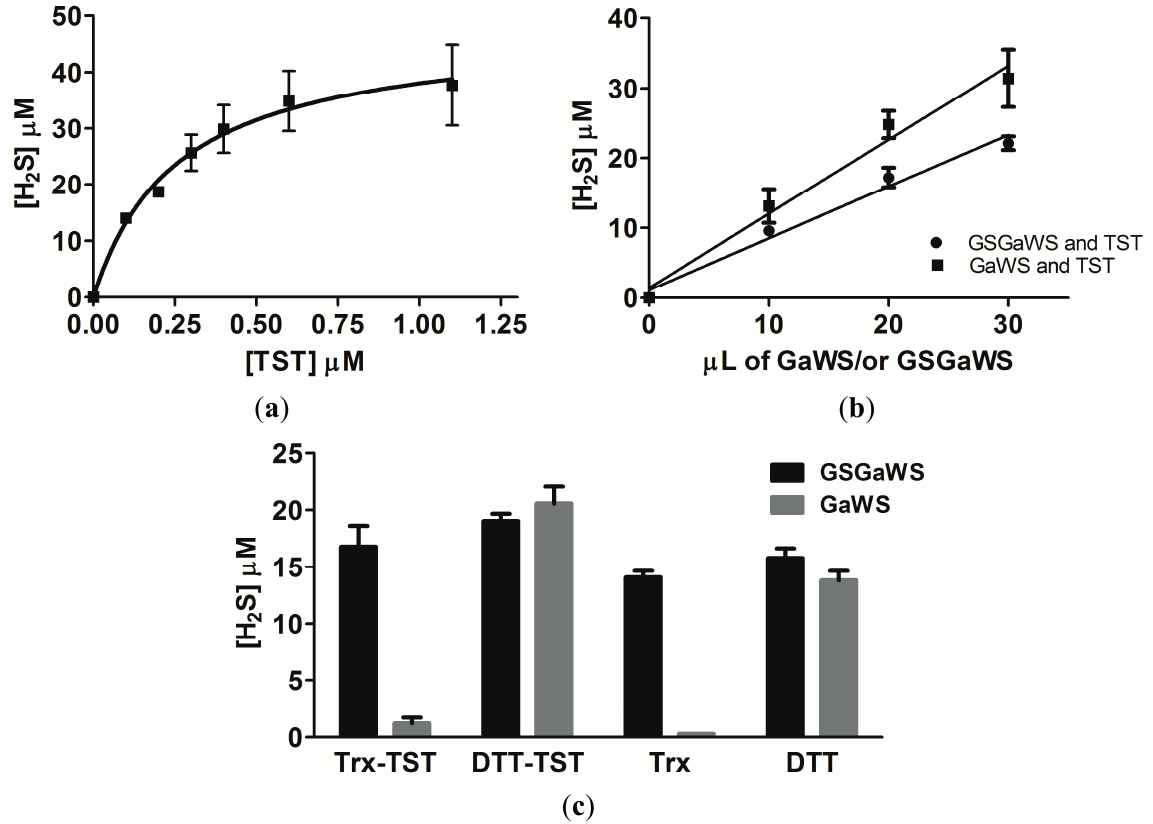
Figure 5. Catalysis of the H 2 S formation by TST enzyme. ( a ) H 2 S formation obtained using different concentrations of TST enzyme in the presence of 3 mM thiosulfate and 1 mM DTT; ( b ) using different concentrations of GaWS and GSGaWS in the presence of 0.22 μ M TST enzyme; and ( c ) by 20 μ L of GaWS (0.64 mg) and of GSGaWS (0.88 mg), in the presence or in the absence of 1.1 μ M TST, with 4 mM DTT or with 4 μ M Thioredoxin. Each bar represents ±SD of three